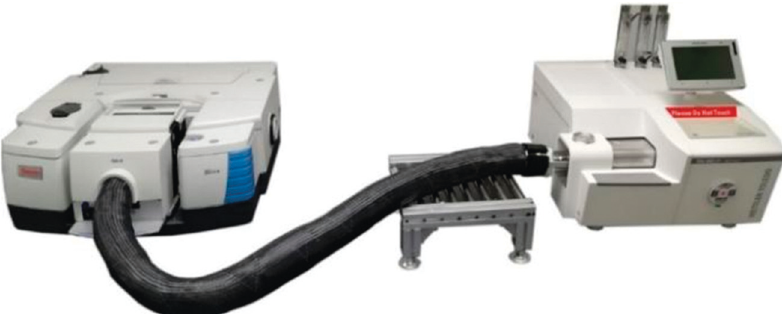
Figure 3: Thermogravimetric-infrared spectroscopy system.